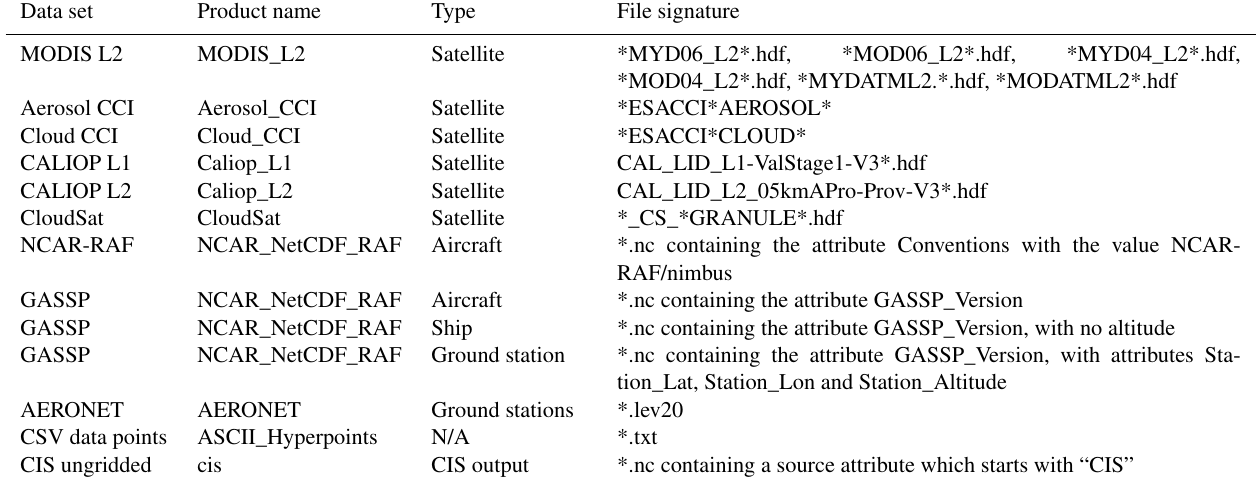
Table 1. A list of the ungridded data sources supported by CIS 1.4.0. The file signature is used by CIS to automatically determine the correct product to use for reading a particular set of data files, although this can easily be overridden by the user. (Internally these signatures are represented as Python regular expressions; here, they are shown as standard wildcards for ease of reading.). The Global Aerosol Synthesis and Science Project (GASSP) data sets are large collections of harmonized in situ aerosol observations from groups around the world (http://gassp.org.uk).